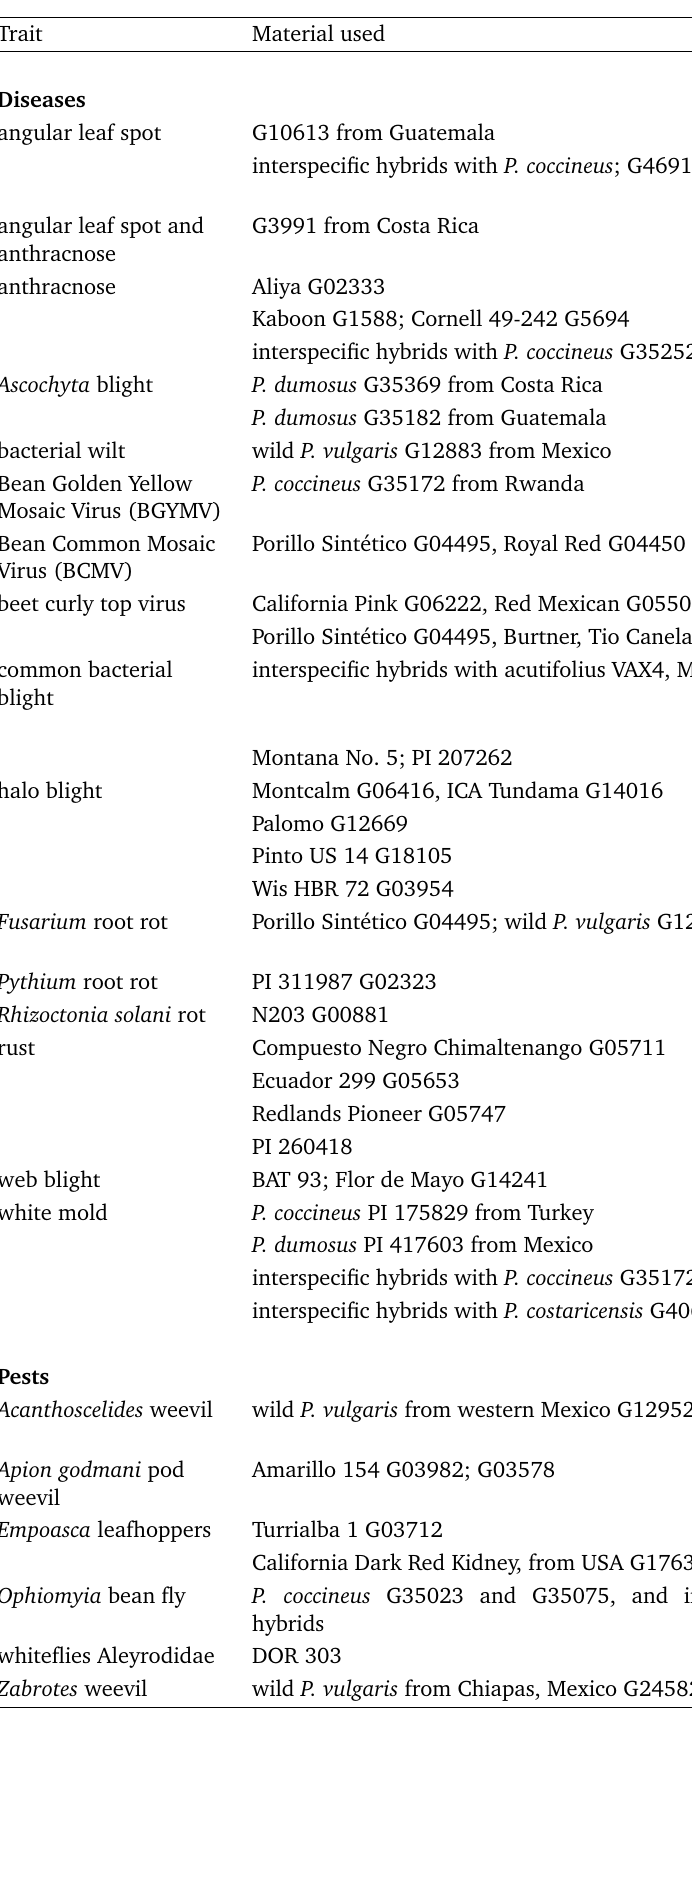
Table 2. Bean accessions from the CIAT collection used as sources of resistance to diseases and